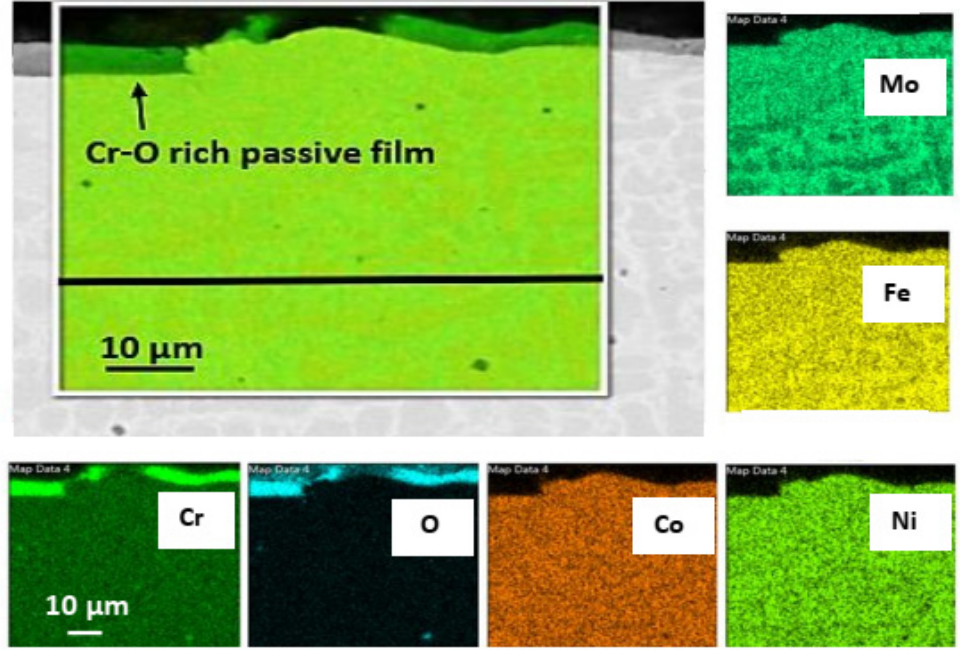
Figure 9. Elemental mapping of the Mo-HEA coating showing the extent of the discontinuous passive film formed on the coating.